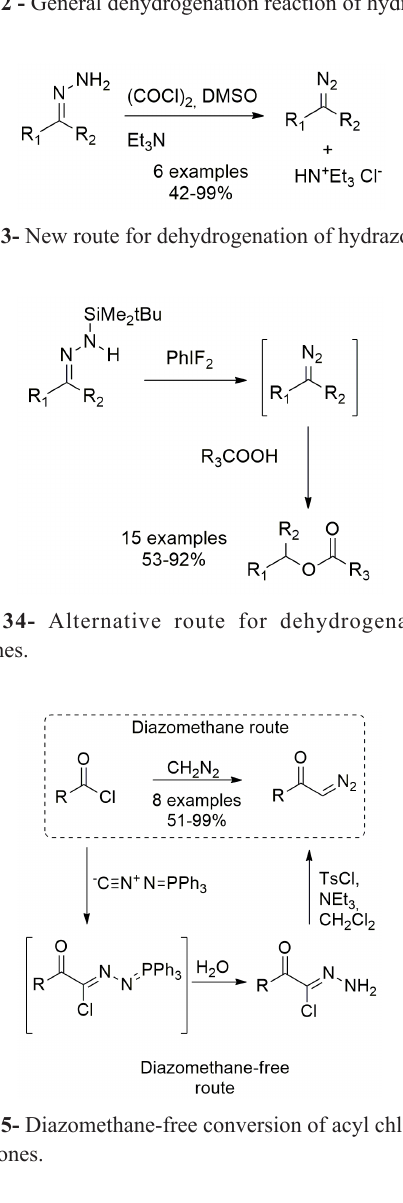
Figure 32 - General dehydrogenation reaction of hydrazones.